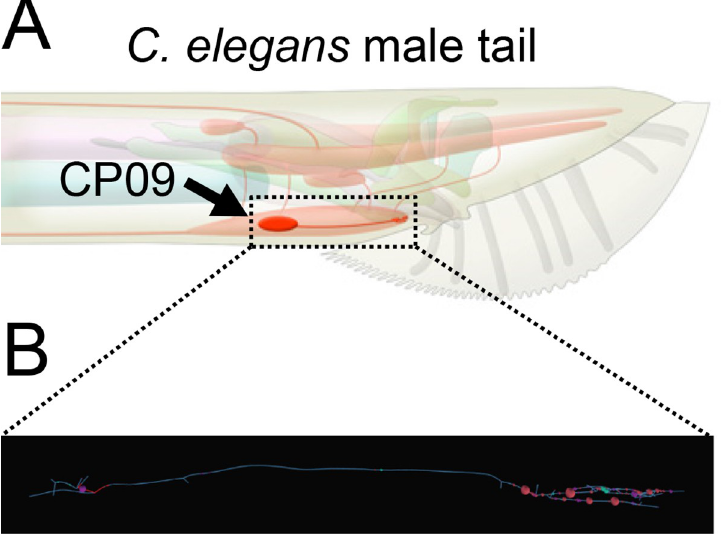
Fig 1. The CP09 neuron in C . elegans . (A) Schematic of the position of cell body and axon of CP09 in the pre-anal ganglion of the C . elegans male tail. Reprinted from [14] under a CC BY license, with permission from